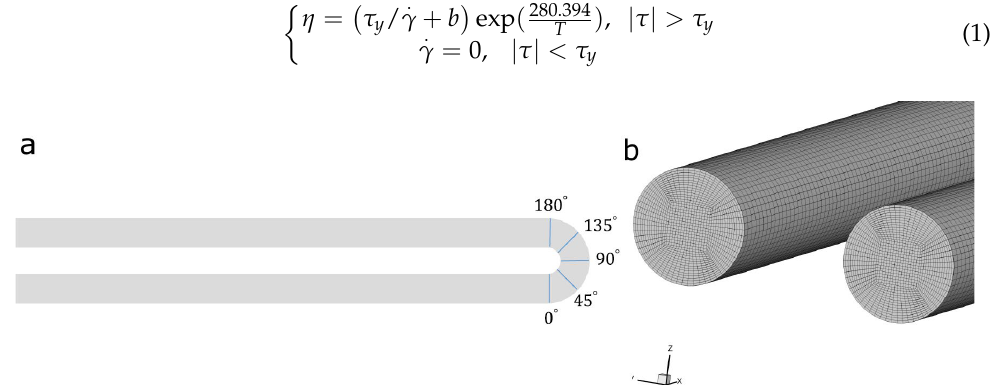
Figure 1. ( a ) The model of the U-shaped channel and the cross sections within the bend at five dif- ferent angles: 0°, 45°, 90°, 135°, and 180°. ( b ) Mesh structures of the U-shaped channel, viewed from angles: 0 ◦ , 45 ◦ , 90 ◦ , 135 ◦ , and 180 ◦ . ( b ) Mesh structures of the U-shaped channel, viewed from the the inlet and the outlet. inlet and the